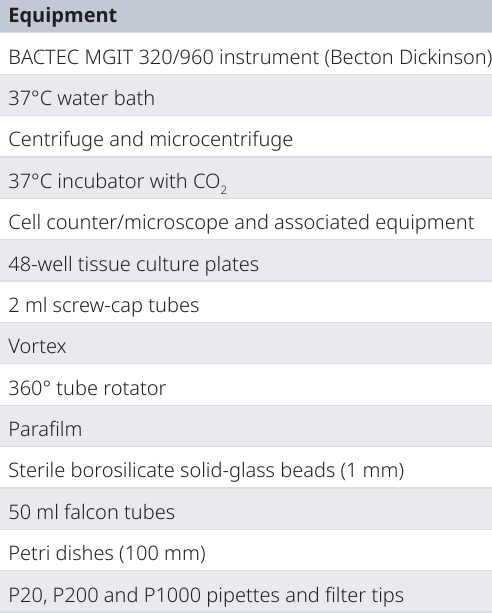
Table 3. Equipment required for the direct PBMC NHP MGIA.